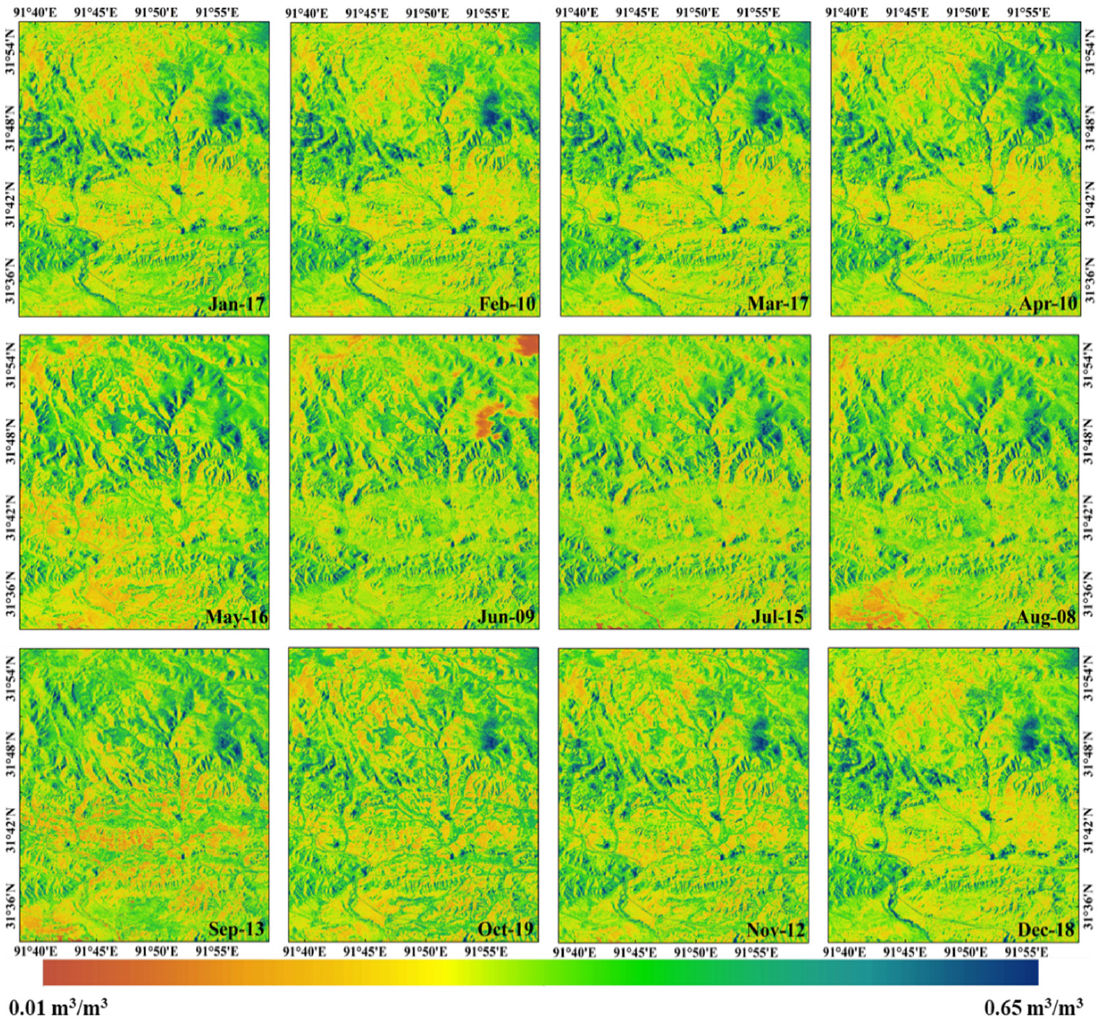
Figure 6. Soil moisture for descending orbit of Naqu network for 2020.